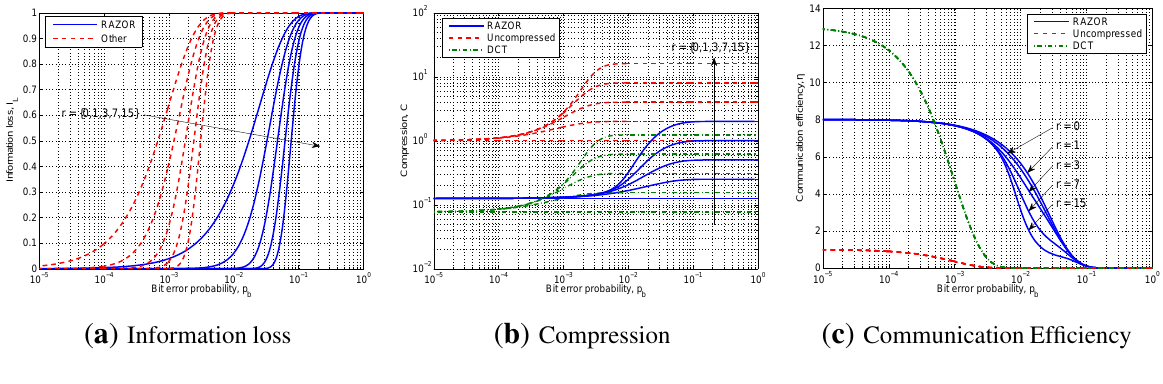
Figure 9. Performance evaluation in lossy channels varying the bit error probability of RAZOR (blue solid line), uncompressed data (red dashed line) and DCT (green dash-dotted line). RAZOR has been compared using three metrics: information loss, I and communication efficiency, η . For each chart, we considered a number of retransmissions r ∈ { 0 , 1 , 3 , 7 , 15 } .